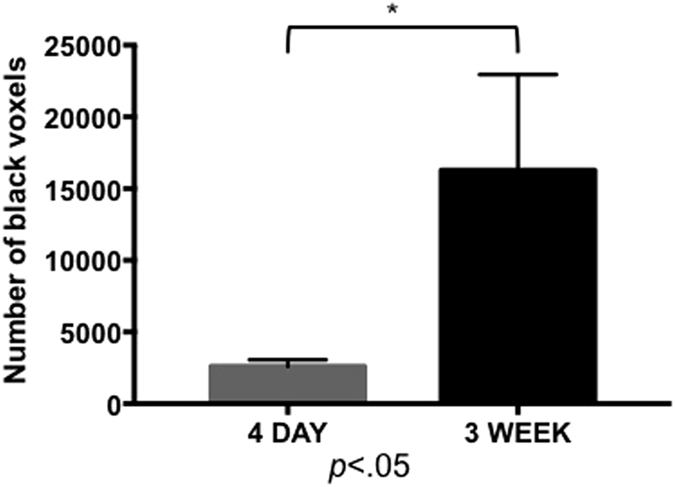
USPIO-based MRI quantification.Signal loss from iron was quantified by measuring the number of black voxels in whole tumor volumes. Mean values with standard deviation are shown for each time point. The asterisk denotes a significantly higher number of black voxels (*p < 0.05; t-test) were detected at 3 weeks (n = 7) compared to 4 days (n = 4).